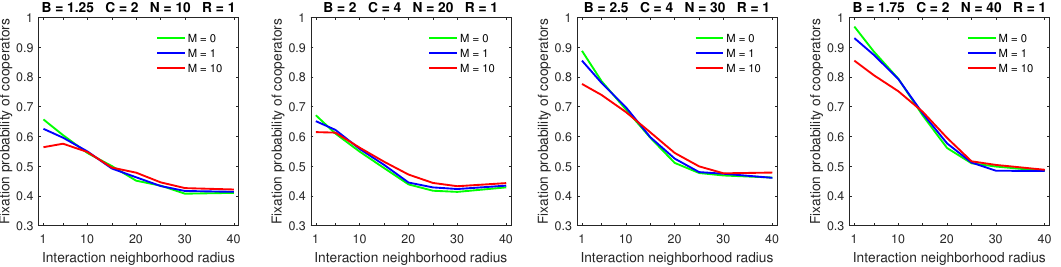
Figure 1. Increasing the mobility rate does not help cooperators in the almost deterministic dispersal model, and it hurts cooperators when interaction neighborhoods are small.